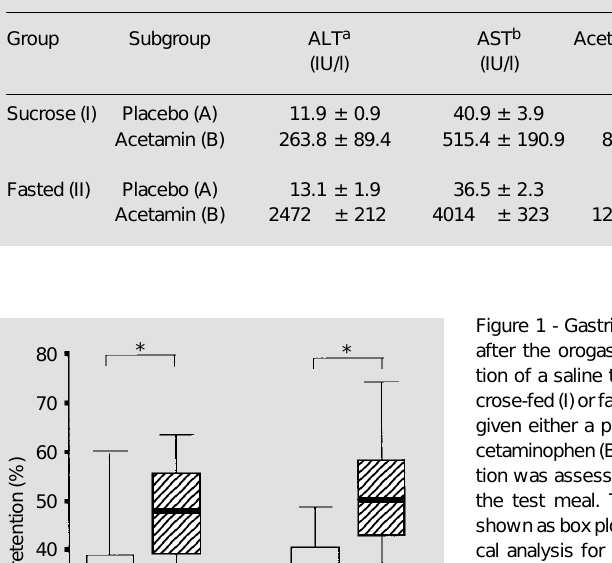
Table 1 - Serum alanine aminotransferase (ALT), aspartate aminotransferase (AST) and acetaminophen (acetamin) levels in the groups of rats studied. The values are reported as the mean ± SEM of 12 rats/subgroup. P<0.05 for a IA vs IB, IB vs IIB, and IIA vs IIB; b IA vs IB, IB vs IIB, and IIA vs IIB and c IB vs IIB (Tukey test).